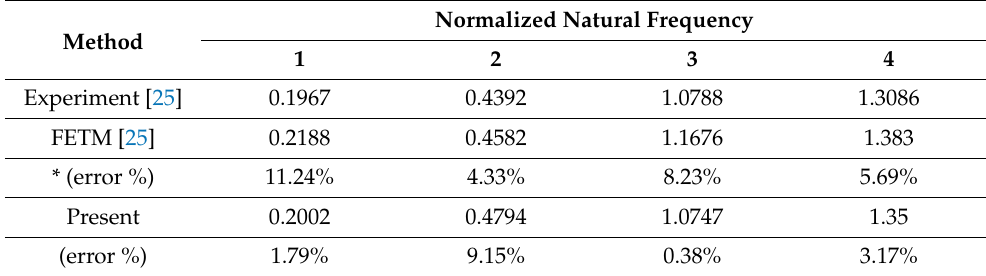
Table 6. Normalized natural frequencies of an isotropic plate ( a / h =